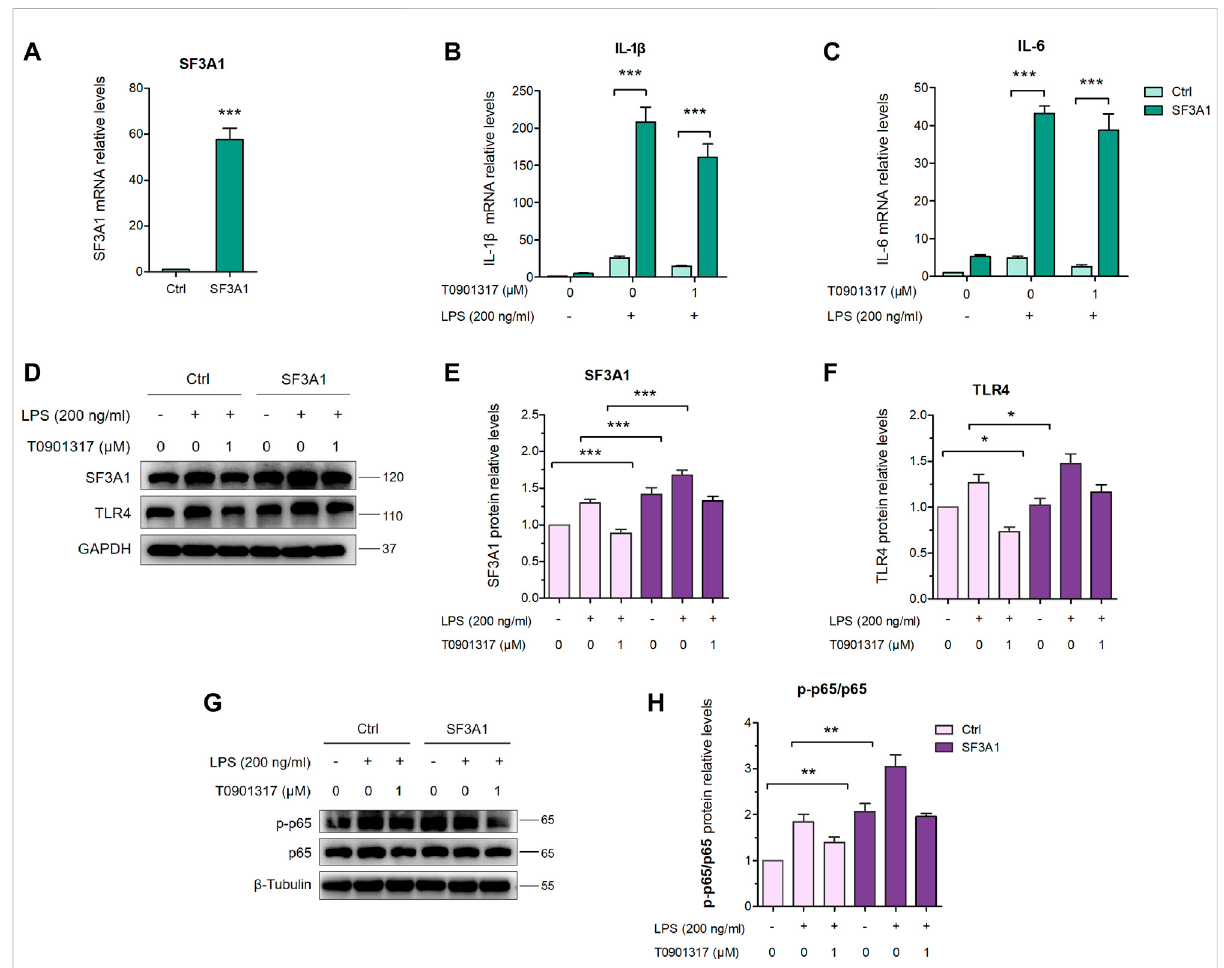
FIGURE 8 Inhibition ofSF3A1synergistically attenuates in fl ammationinTLR4-mediatedNF- κ Bpathway. (A – C) RAW264.7 weremacrophagestransfected withorwithoutpCMV3-Flag-SF3A1plasmidfor24 h,followedbypretreatingwithT0901317(0or1 μ M)for18 h,thenstimulatedwithorwithoutLPS (200 ng/mL) for 3 h. SF3A1, IL-1 β and IL-6 mRNA levels were measured by qPCR. All mRNA levels were normalized to GAPDH. (D – F) Cells were transfected with or without pCMV3-Flag-SF3A1 plasmid for 24 h, followed by treating with or without LPS (200 ng/mL) and T0901317 (0 or 1 μ M) for 18 h, then protein levels of SF3A1 and TLR4 were measured by western blot, normalized to GAPDH. (G,H) RAW264.7 macrophages were transfectedwith or without pCMV3-Flag-SF3A1 plasmid for 24 h, followed by pretreating with T0901317 (0 or1 μ M) for 18 h, then stimulated with or without LPS (200 ng/mL) for 1 h. Phosphorylated p65 and p65 protein levels were measured by western blot. Phosphorylated p65 protein level